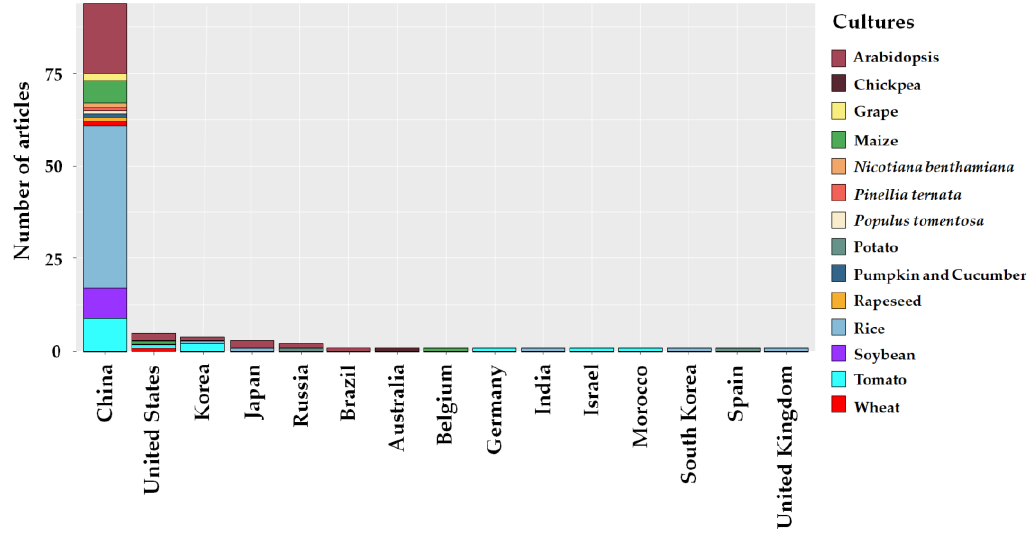
Figure 4. Main countries that have studied CRISPR/Cas being used to edit abiotic stress tolerance genes in the last seven years.